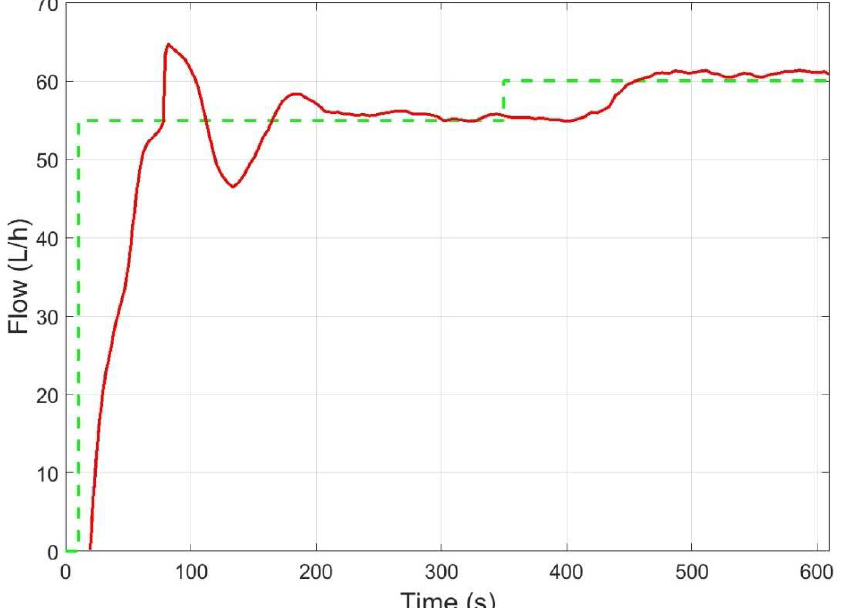
Figure 8. Control dynamics of ANN controller (flow rate reference in dashed green and flow output in red).